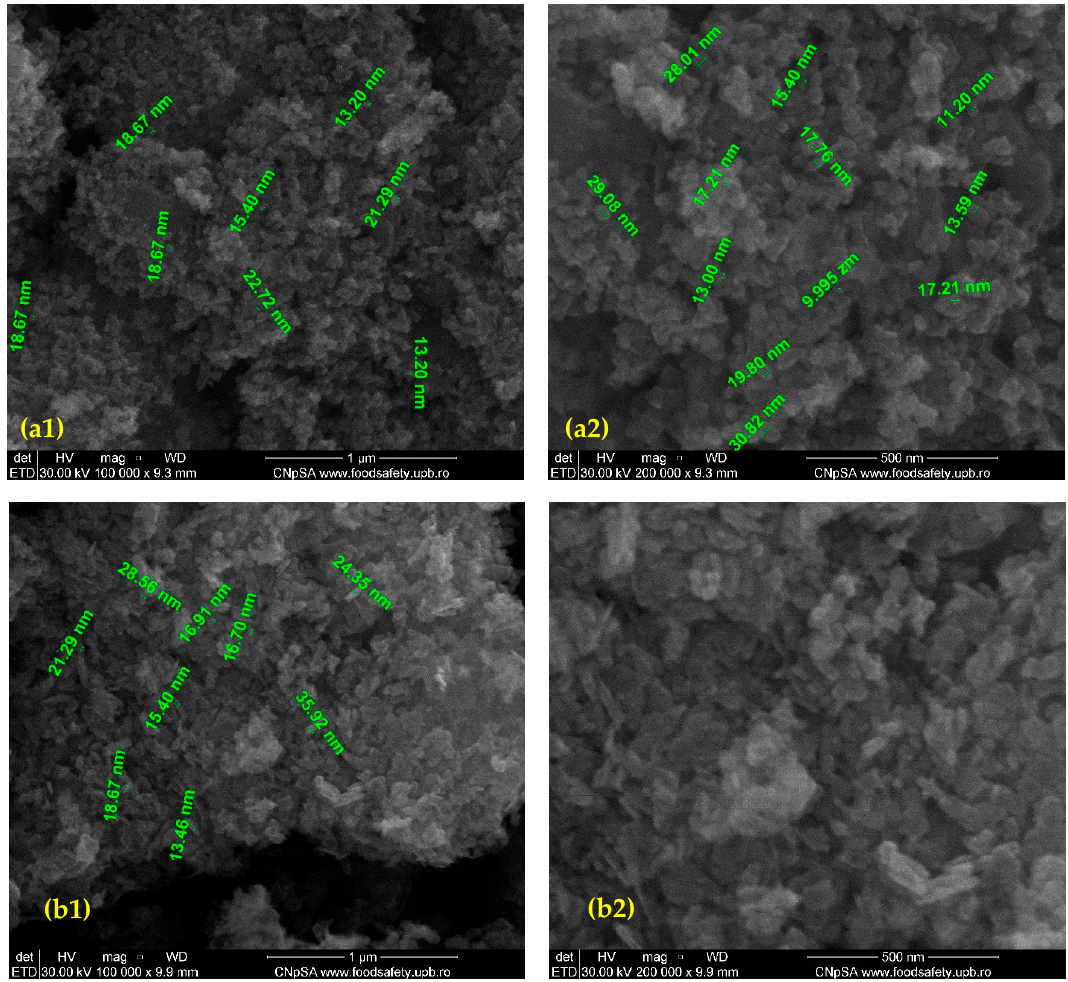
Figure 2. SEM image of bare ZnO NPs ( a1 , a2 ) and ZnO@LiN NPs ( b1 , b2 ).